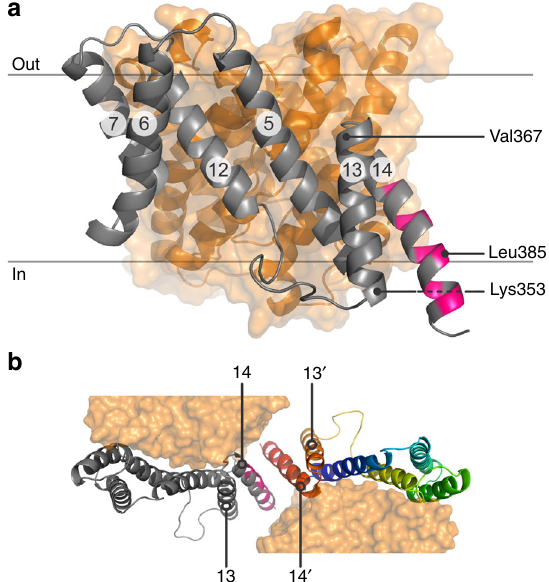
Fig. 3 Model of the SLC26Dg dimer interface. a Side view of the SLC26Dg membrane domain in the same orientation as Fig. 1a. Core and gate domain are colored orange and gray, respectively, with residues within 4 Å of the opposing protomer in pink. b Top views of the dimeric arrangement of SLC26Dg. The gate domain of one of the protomers follows a rainbow coloring scheme (blue-to-red for N-to-C